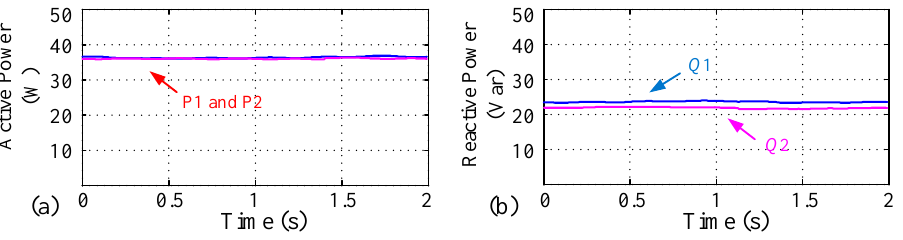
Figure 22. Steady-state power of Case III: ( a ) active power, and ( b ) reactive power.